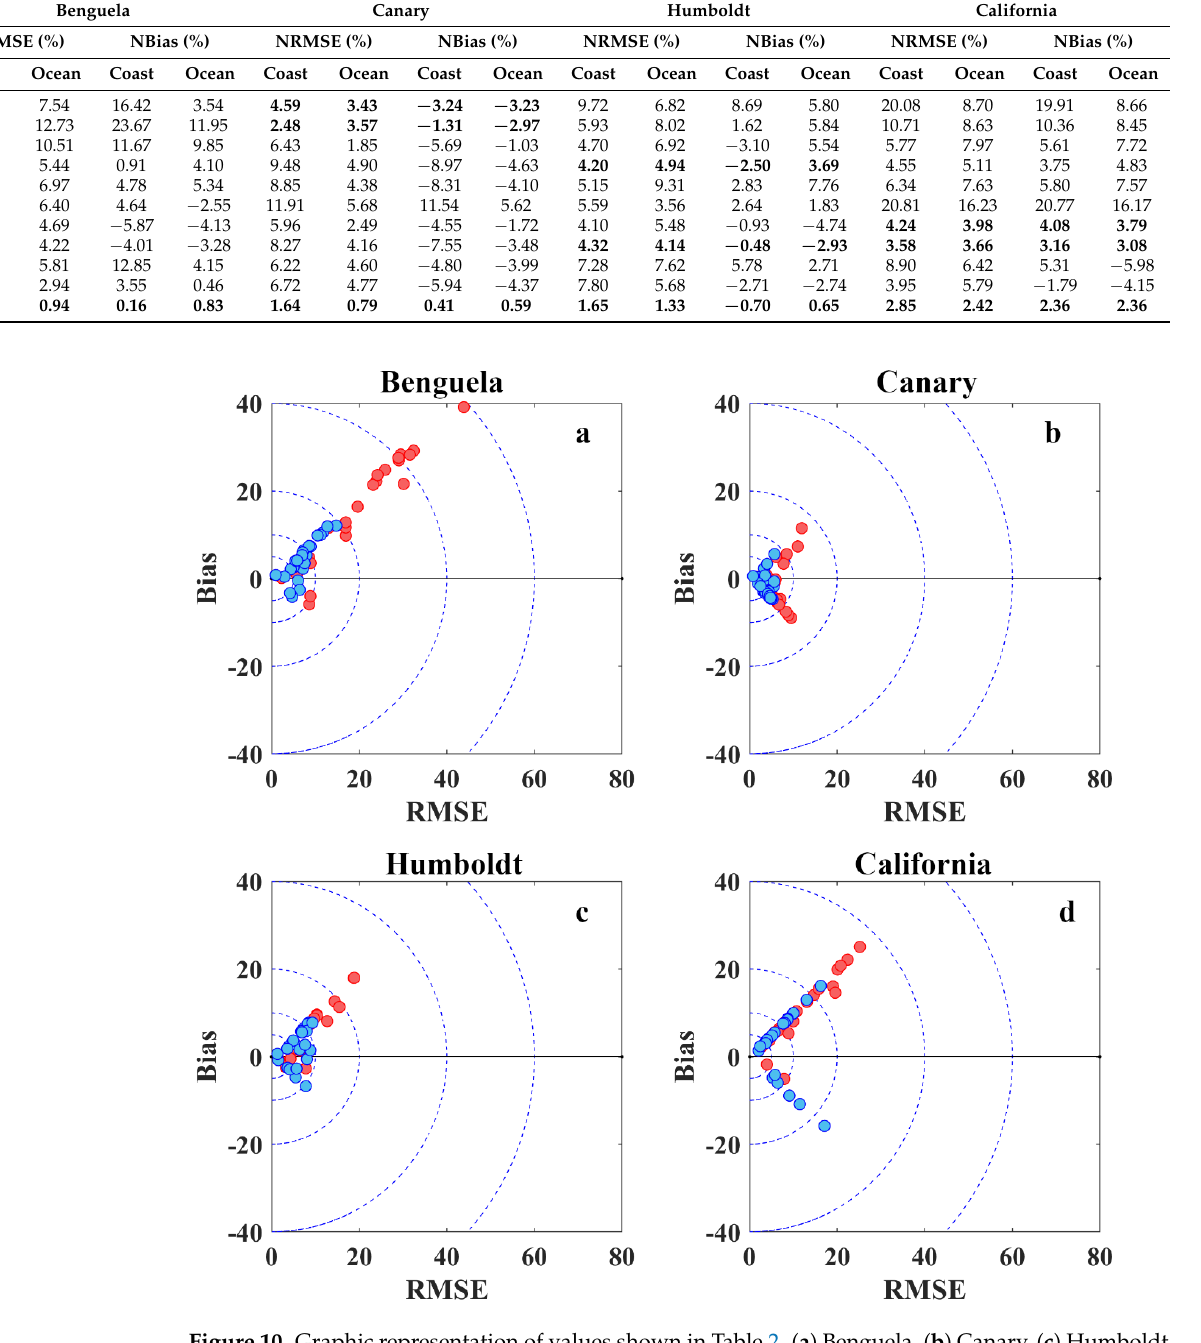
Figure 10. Graphic representation of values shown in Table 2. ( a ) Benguela, ( b ) Canary, ( c ) Humboldt, and ( d ) California. Red (blue) circles represent coastal (oceanic) locations.